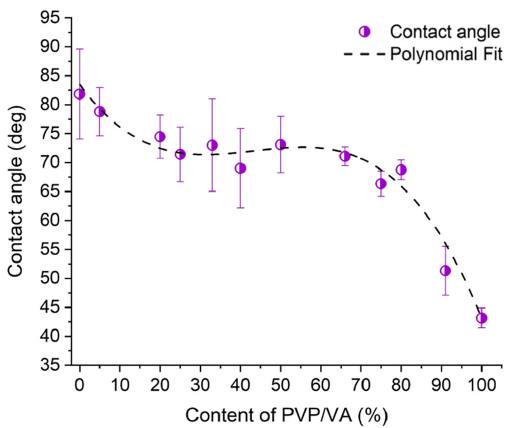
Figure 6. Contact angle of raw EZT and EZT-PVP/VA solid dispersions plotted as a function of the carrier concentration (circles) with fitted polynomial curve (dotted line) .